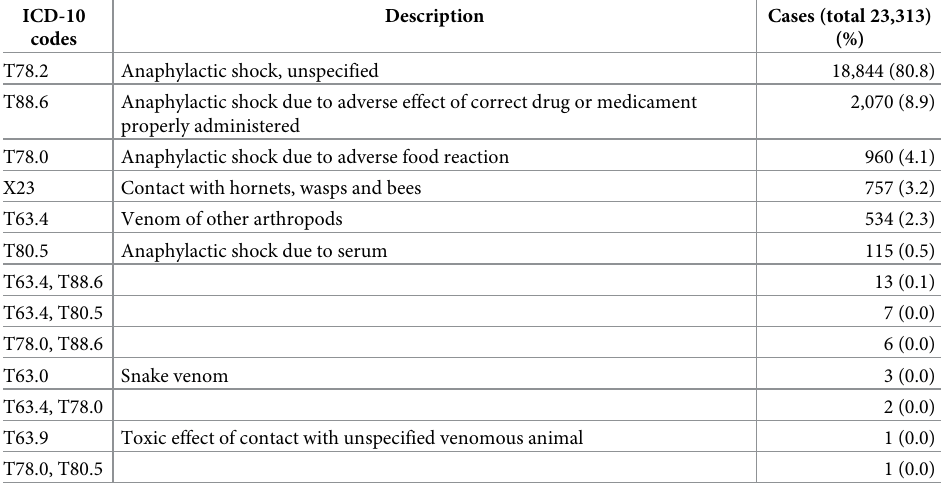
Table 2. The number of cases of ICD-10 codes.